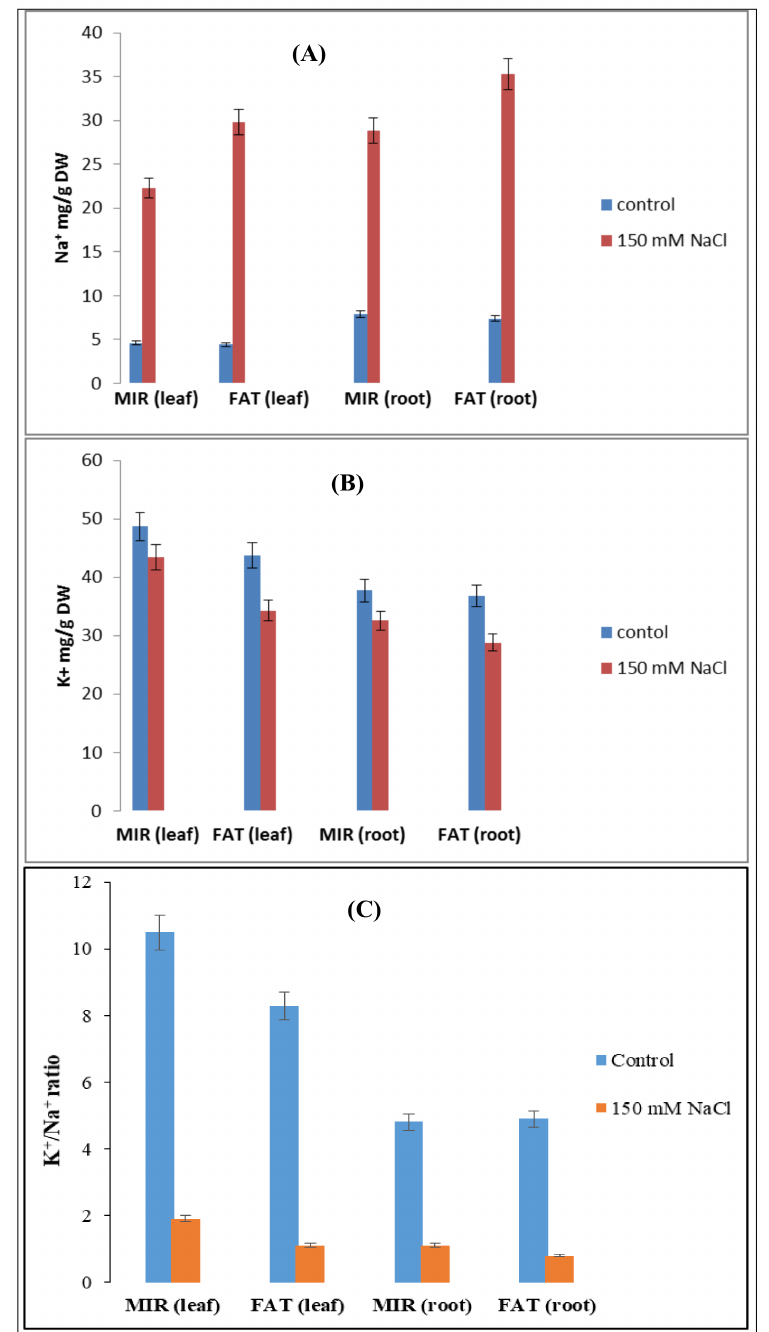
Figure 4. Effect of 150 mM NaCl on Na + ( A ) content, K + ( B ) content, K + /Na + ratio ( C) in roots and leaves of salt-tolerant Mirbashir 128 (MIR) and salt-sensitive Fatima (FAT) wheat genotypes after 10 days of salt treatment. The values of standard error ( ± SE) in each bar were calculated for each treatment from three